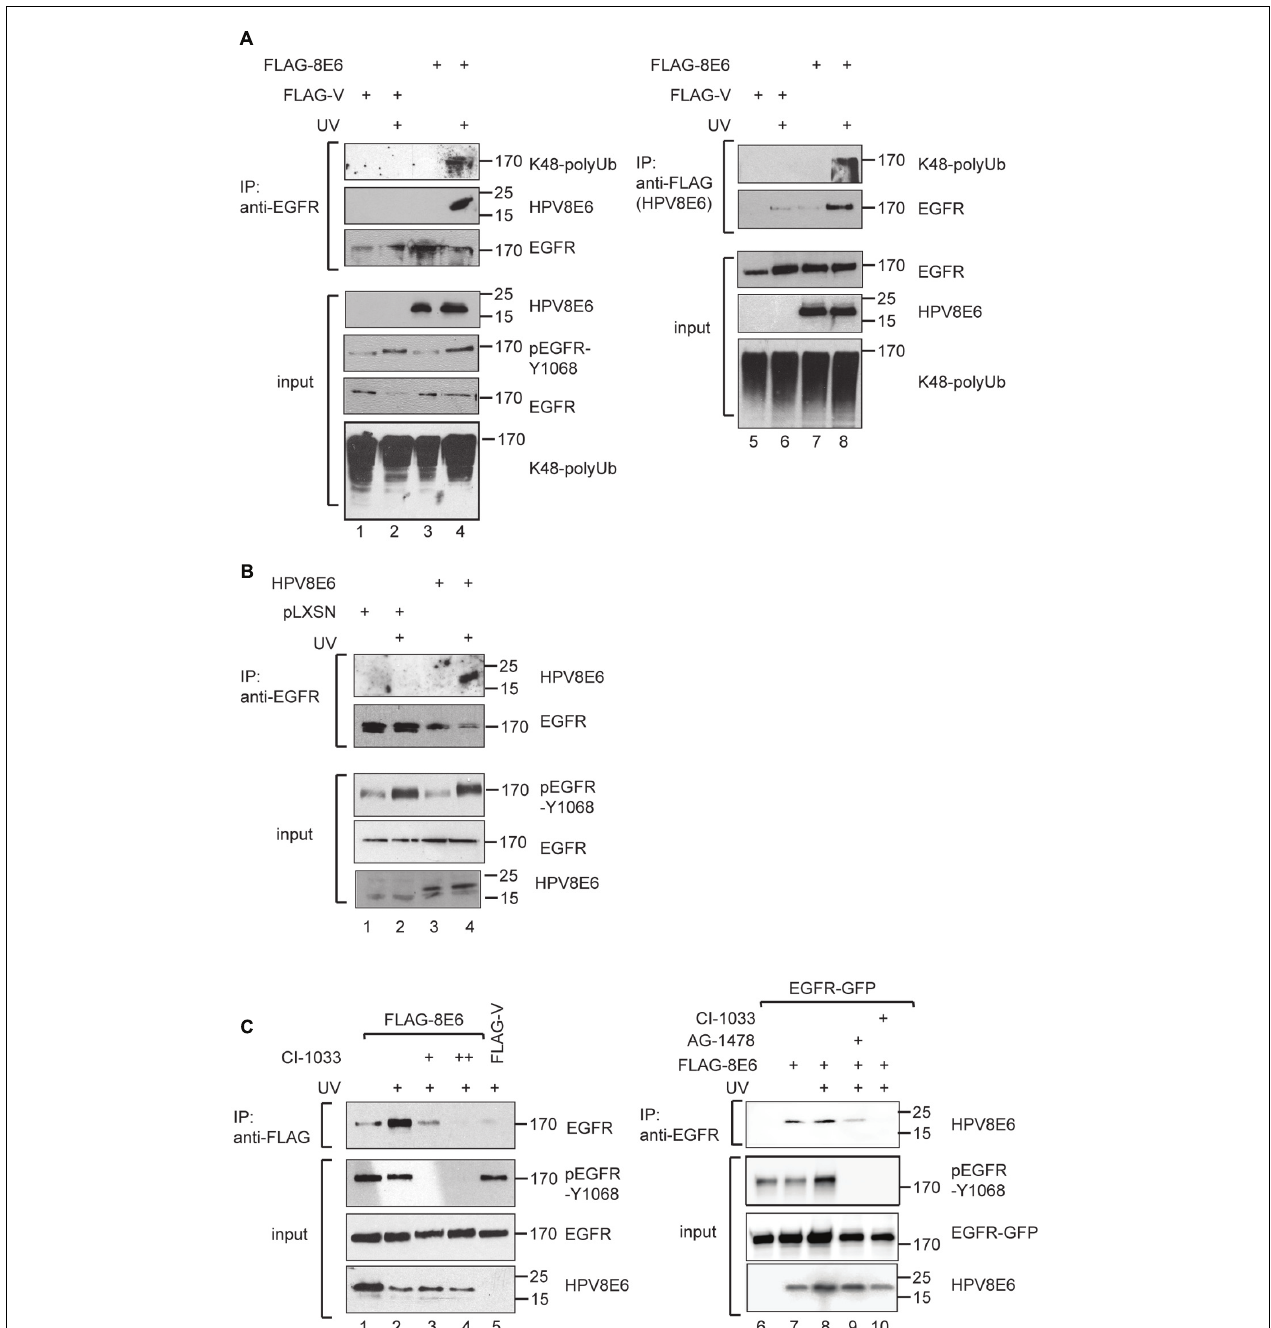
FIGURE 3 | HPV8E6 directly binds to the ubiquitinated EGFR in an UV-dependent manner. (A) RTS3b cells were transiently transfected with a vector directing the expression of FLAG-tagged HPV8E6 under control of the CMV-promoter or the empty vector. Where indicated the cells have been irradiated with UV-light 30 min prior harvesting. 400 µ g of extracts were incubated with the anti-EGFR-antibody (lanes 1–4) or with the FLAG-antibody (lanes 5–8), both coupled to sepharose, washed four times in 0.3 M KCl-buffer prior analysis by WB and 40 µ g of the extracts were used in the input blots. (B) IP with anti-EGFR sepharose and 800 µ g of extracts derived from the stable RTS3b-pLXSN and RTS3b-HPV8E6 lines, either left untreated or UV-irradiated 30 min prior harvesting. FLAG-HPV8E6 and EGFR present in the precipitate as well as in the input were detected by WB. (C) Extracts from UV-irradiated RTS3b cells that have been transiently transfected with the FLAG-HPV8E6 or the FLAG-vector were incubated either with DMSO (lanes 1, 2, 5), 3 µ M (lane 3) or 7 µ M (lane 4) Canertinib for 30 min. The IP was performed with the FLAG-antibody. All WB were developed with the indicated antibodies. In lanes 6–10, C33A cells were transiently transfected with expression vectors for EGFR-GFP and FLAG-HPV8E6, and UV-irradiated, where indicated, prior harvesting 30 min later. EGFR-GFP was precipitated from 400 µ g of extract by the EGFR antibody and bound HPV8E6 was detected by the FLAG-antibody. The input blots were developed with the antibodies against pEGFR-Y1068, GFP, and FLAG. The positions of the molecular weight markers are provided (in